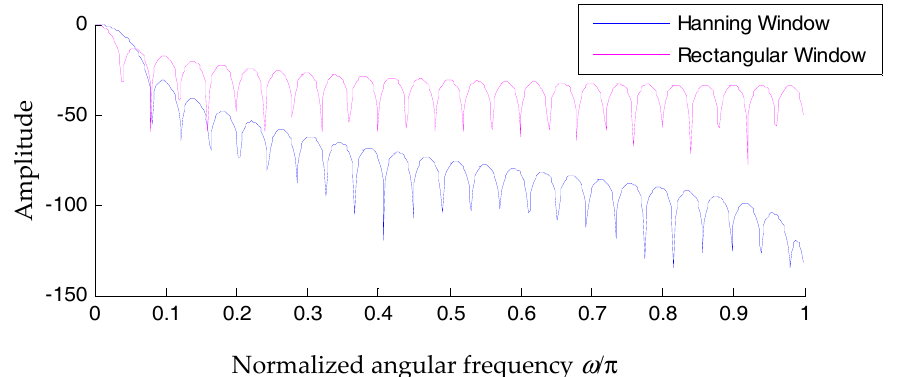
Figure 4. Comparison between the magnitude spectra of a rectangular window and the Hanning window.